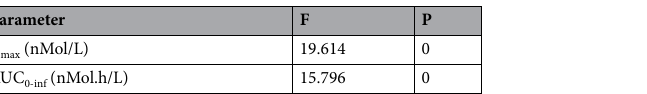
Table 4. One way ANOVA results at P < 0.05 for C max and AUC 0-inf after administration of 25 mg empagliflozin in German 13, 15, 20, 38 , Japanese 11 , and Chinese subjects 9 . F-test is a statistical test in which the test statistic has an F-distribution under the null hypothesis; P is the probability using a given statistical model using ANOVA. Abbreviations: AUC = area under the curve.